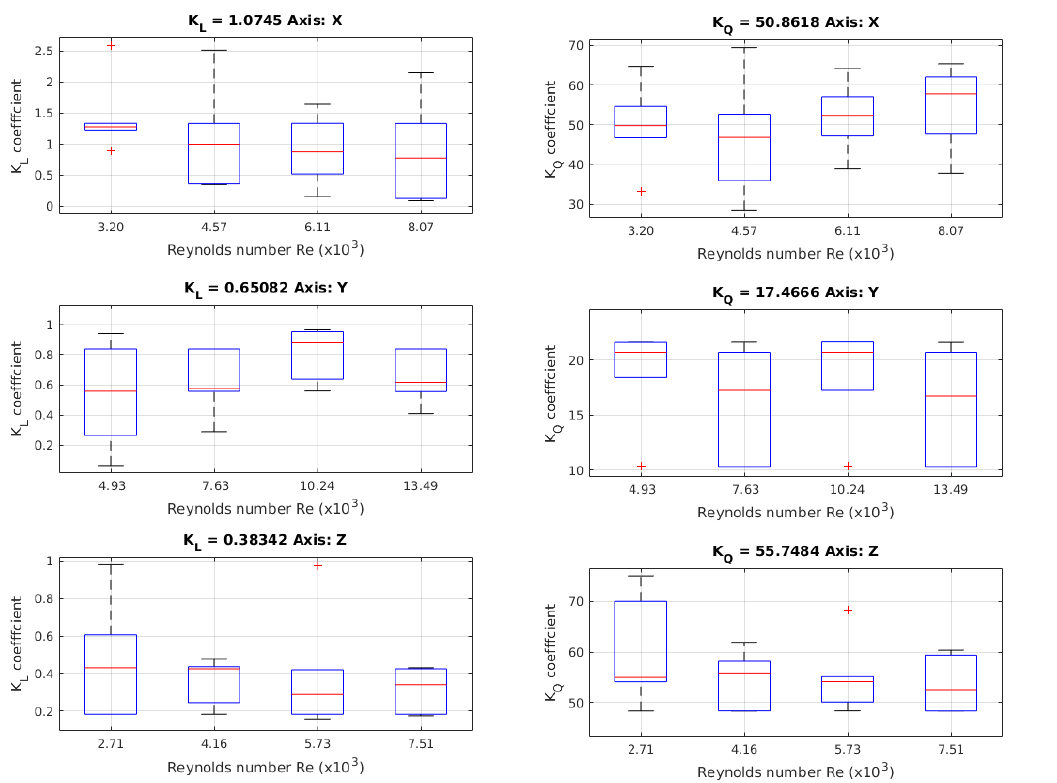
Figure 12. Values of the linear coefficient obtained in the free decay pendulum test. This value is not present in the Morison equation, but is added to take into account other hydrodynamic phenomena.